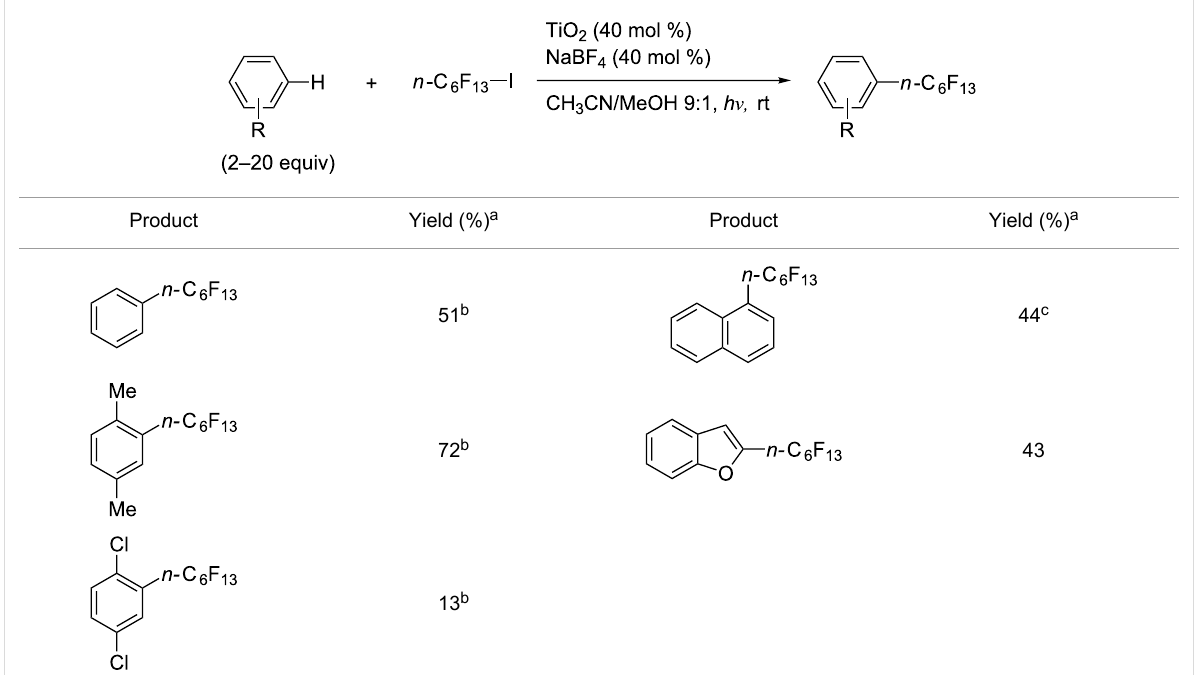
Table 41: TiO 2 -photocatalytic perfluoroalkylations of benzenes